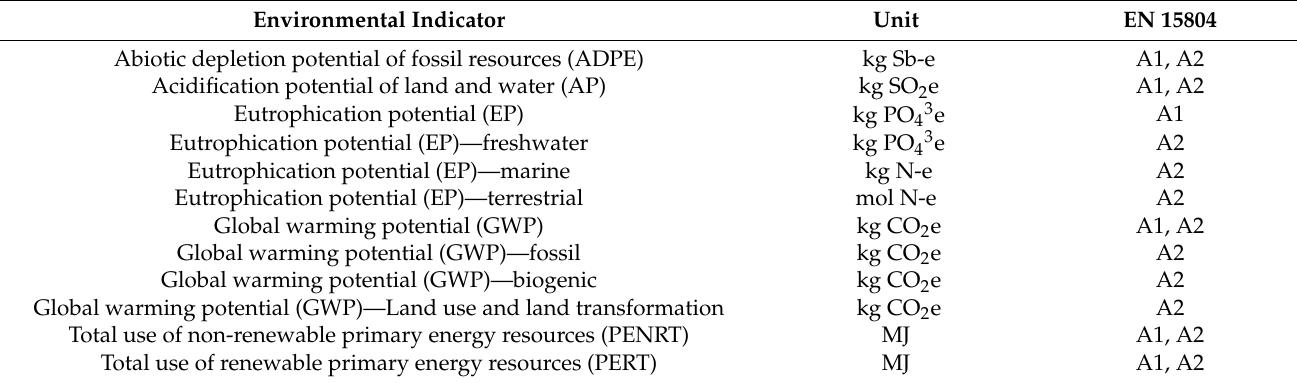
Figure 1. Life cycle stages, as defined in EN 15804, included in the study are highlighted in dark blue. Table 2. Environmental indicators, units, and which version of the EN 15804 standard they are included in. e denotes equivalents.